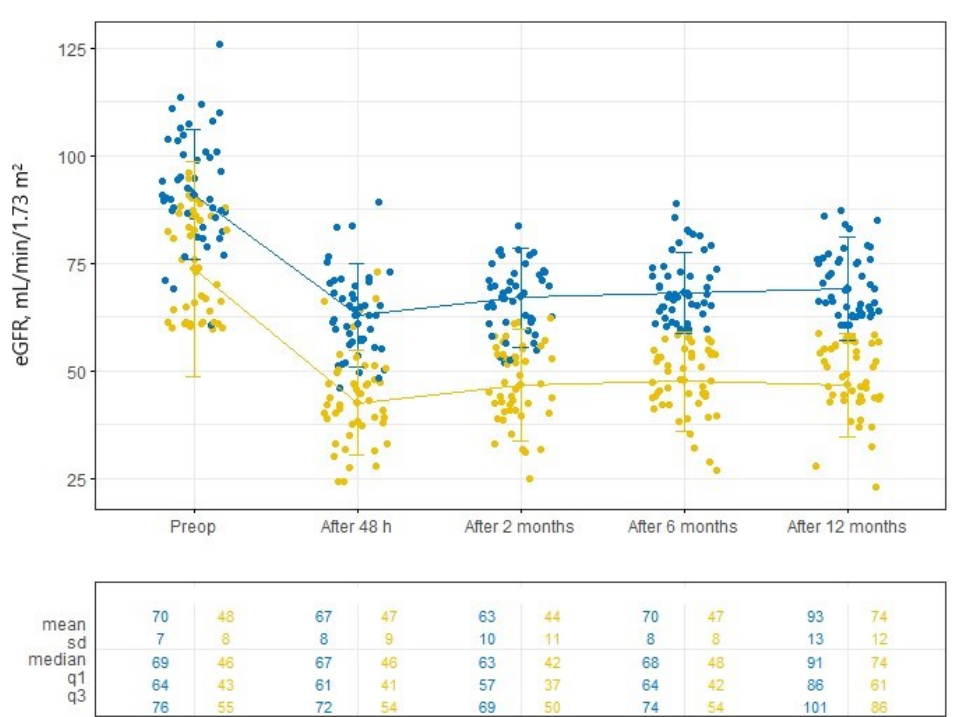
Figure 3. Preoperative and postoperative eGFR changes after RN. Abbreviations: eGFR—estimated glomerular filtration rate; CKD—chronic kidney disease.